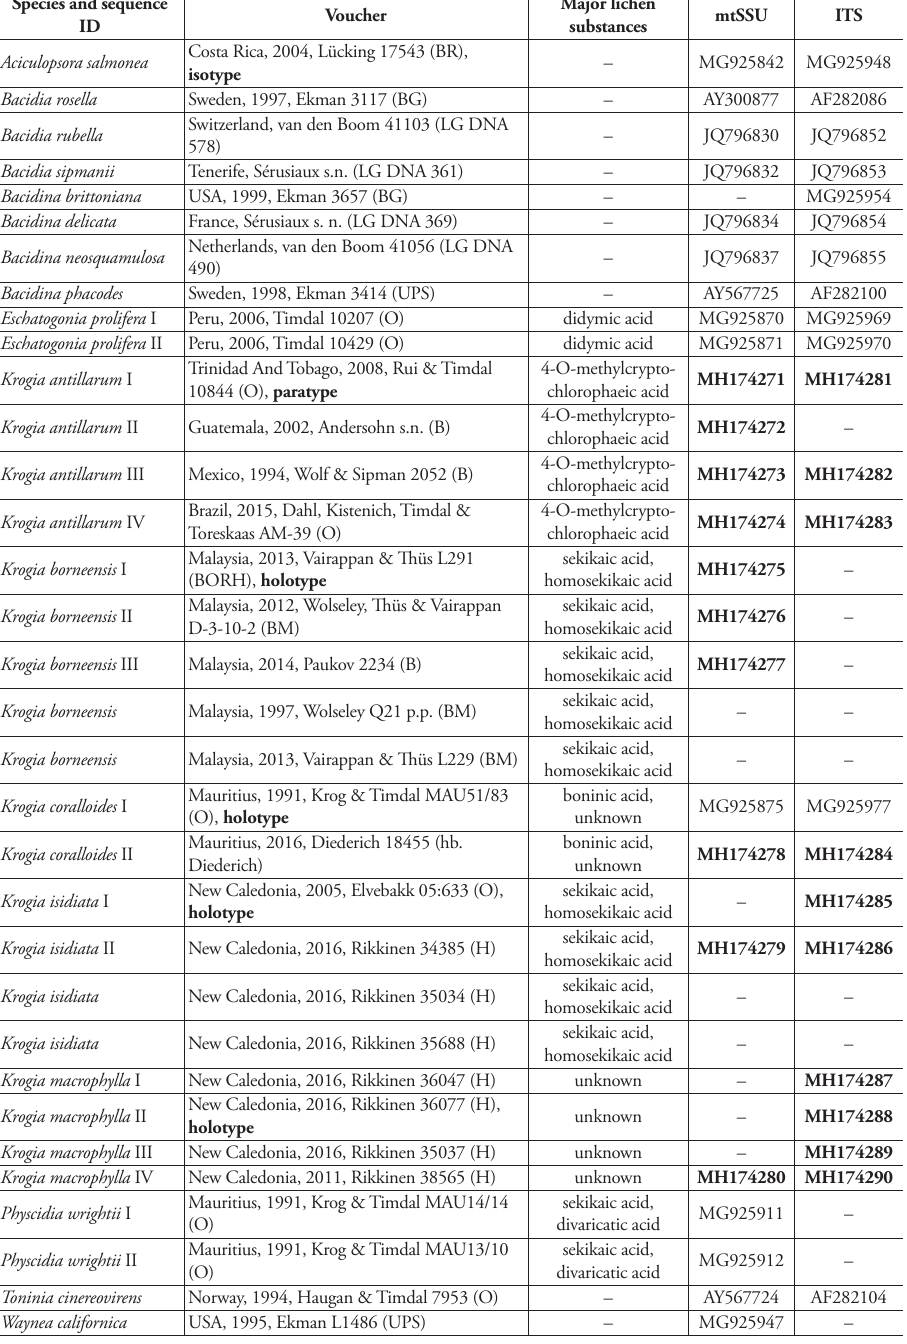
Table 1. Specimens used in this study with voucher information, major lichen substances and GenBank accession numbers. New sequences are indicated by accession numbers in bold. Species and sequence